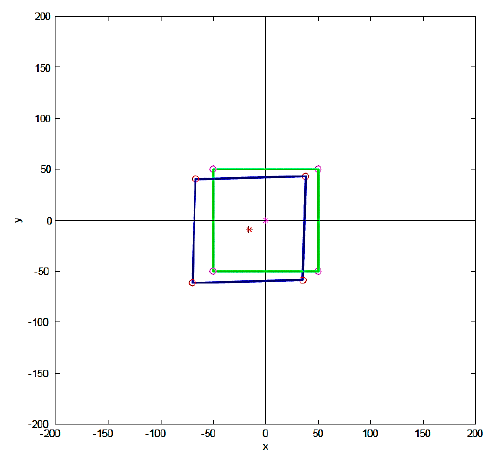
Figure 18. MATLAB calculation predicts single rectangular microstructure rotation angle π /9°, tilt angle π /6°.